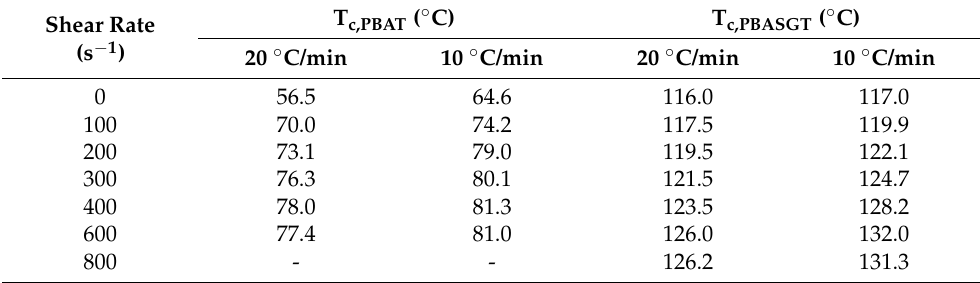
Table 1. The effect of cooling rate on T c of PBAT and PBASGT films sheared for 45 s.